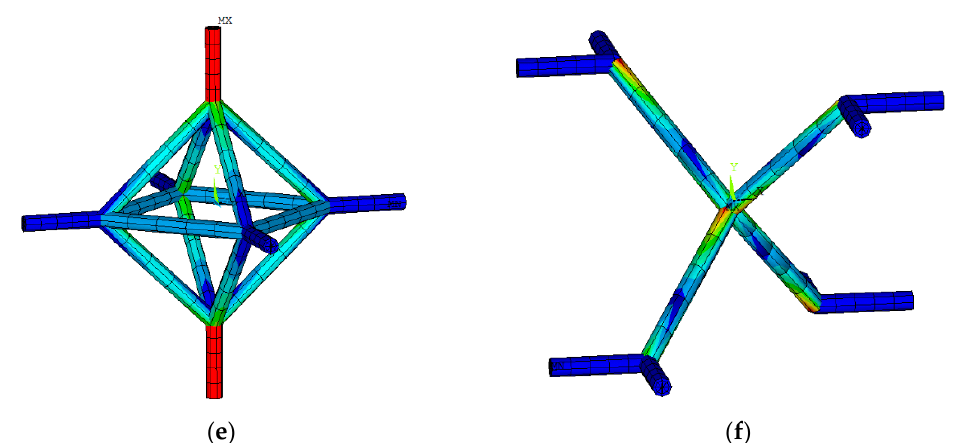
Figure 9. Unit cells stress contour for ( a ) BCC, ( b ) diamond, ( c ) hexagonal packing, ( d ) rhombicuboctahedron, ( e ) truncated cube, and ( f ) truncated octahedron unit cells.